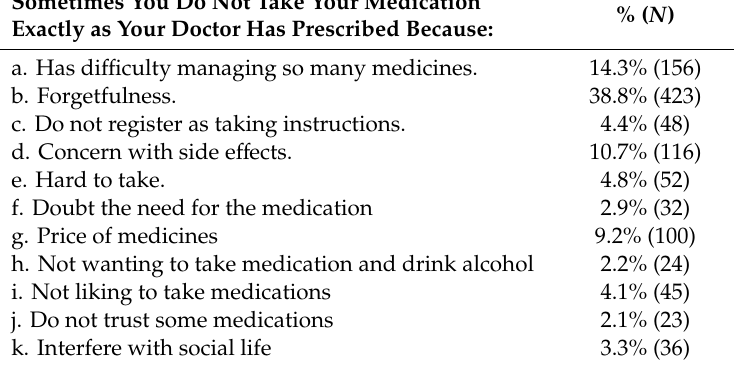
Table 5. Frequencies on the reasons to not take the medication as prescribed.